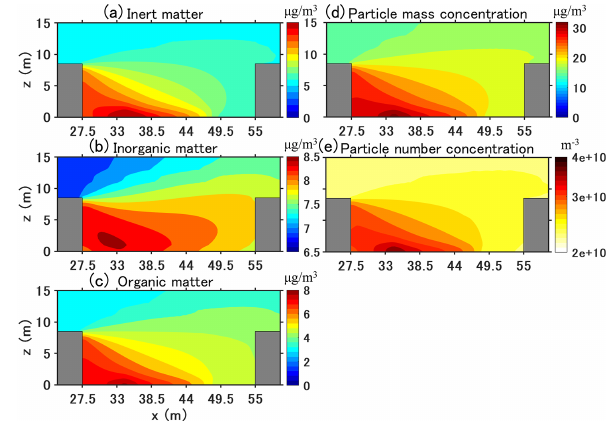
Figure 13. Time-averaged concentrations of particle number, mass, and composition in the street canyon from 05:00LT to 17:00LT. The unit is µgm − 3 for mass concentration and m − 3 for number concentration.